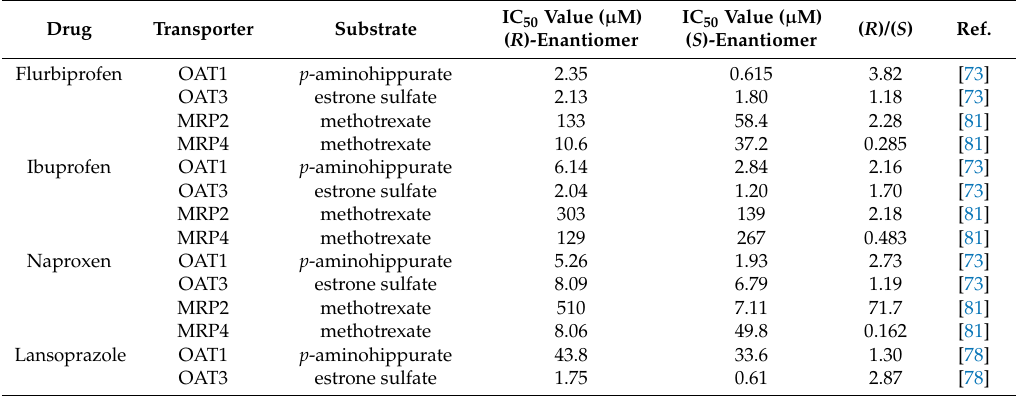
Table 4. IC 50 values of each enantiomer of NSAIDs and lansoprazole for OAT1, OAT3, MRP2, and MRP4.